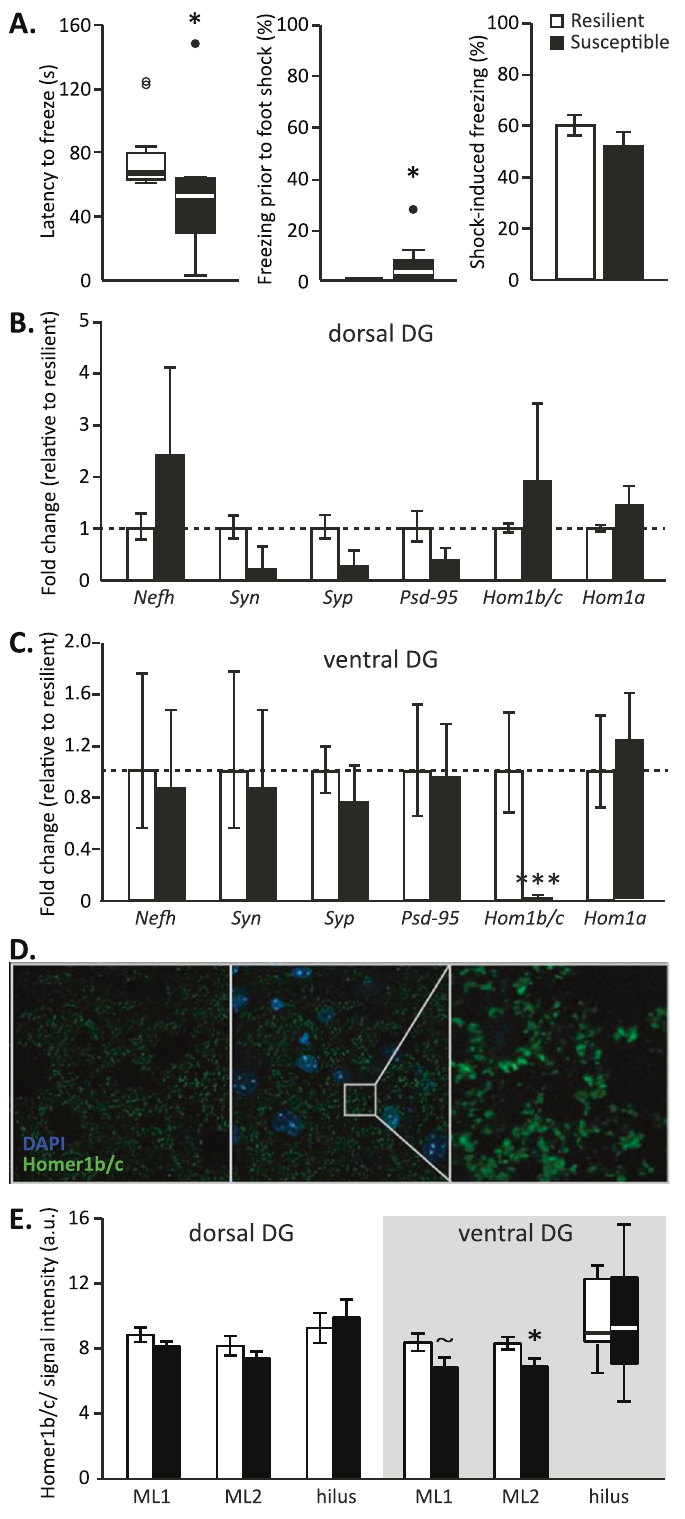
exposure, susceptible animals tended to show a somewhat longer latency to start freezing during its recall (t(8.314) = 2.119, p = 0.066, Fig. 3B). Examination of the freezing levels of susceptible and resilient animals over time revealed a signi fi cant effect of time (F(3.897,54.561) = 3.081, p = 0.024), with